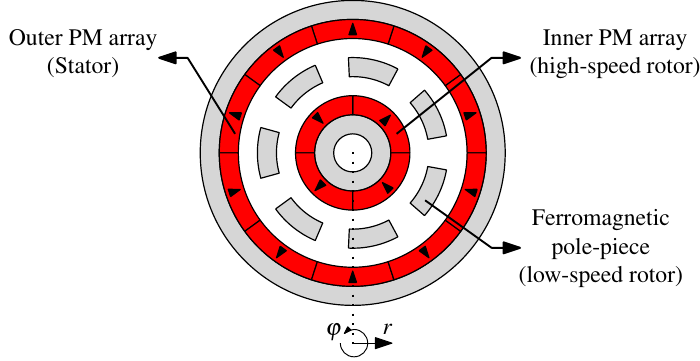
Figure 1. Topology of the investigated magnetic gear.